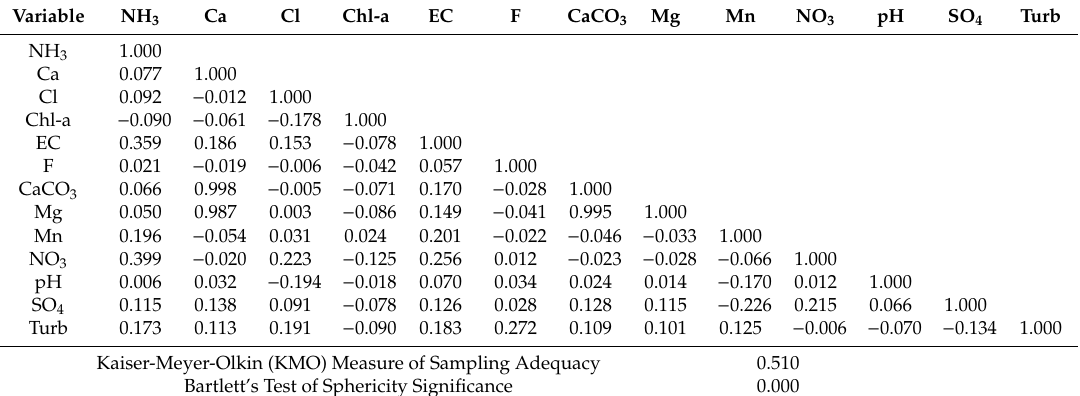
Table 4. Correlation Matrix, Kaiser-Meyer-Olkin (KMO) and Bartlett’s Test Results for Thirteen Physico-Chemical Variables Shortlisted for Multivariate Statistical Analysis.